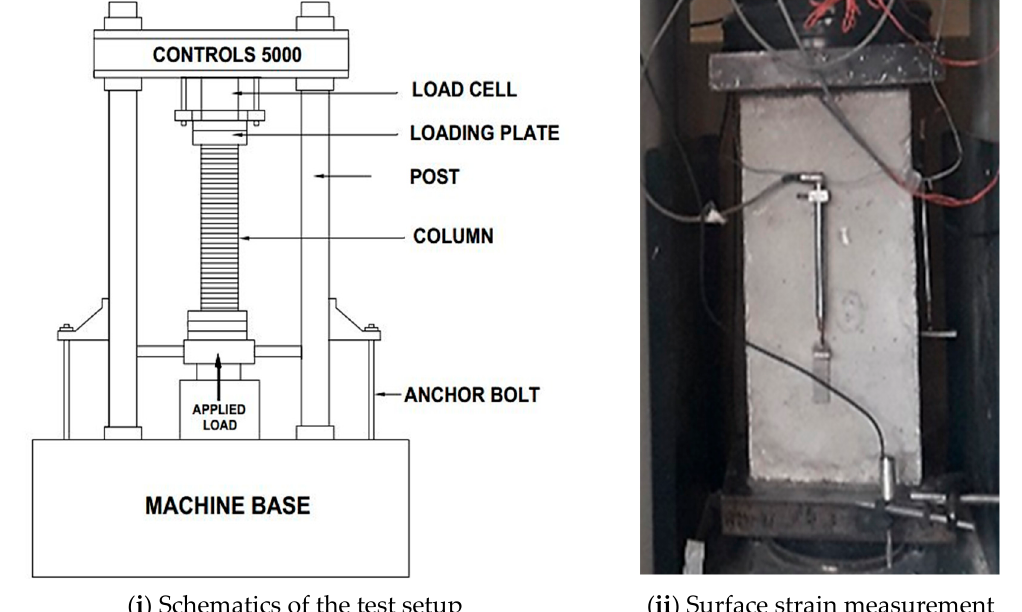
Figure 2. Test setup and surface strain measurement for RC columns under axial loading.